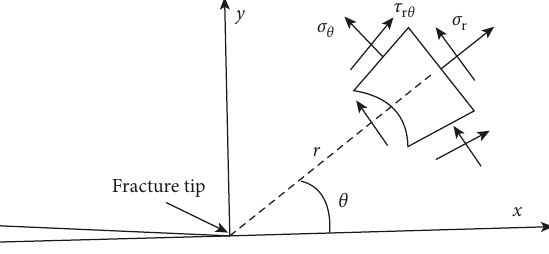
Figure 6: Stresses at the fracture